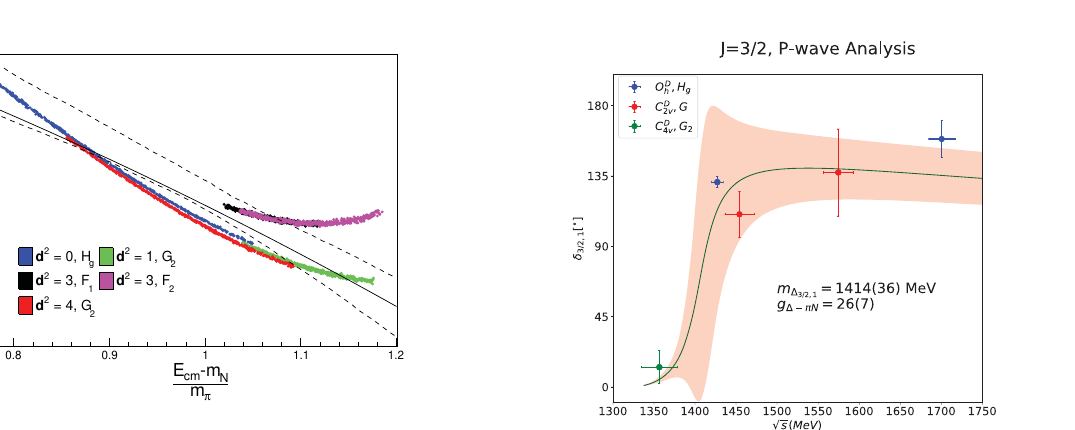
Figure 12. P -wave N π scattering phase shift against the Mandel- √ s showing the Δ resonance where the phase shift stam variable rises dramatically. Results are from Ref. [16].